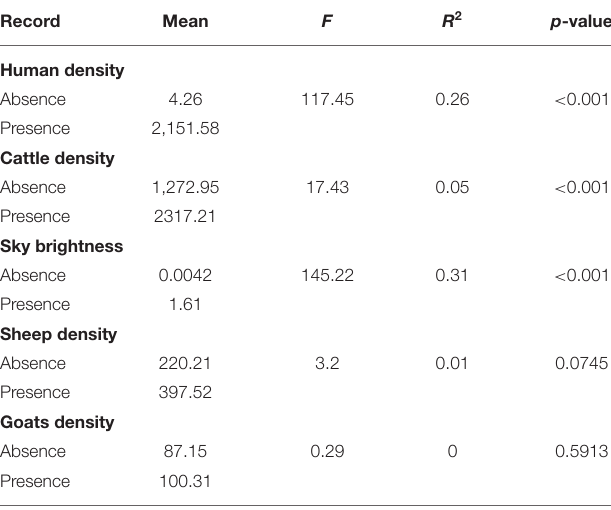
TABLE 1 | Results of one-way ANOVA for the five continuous